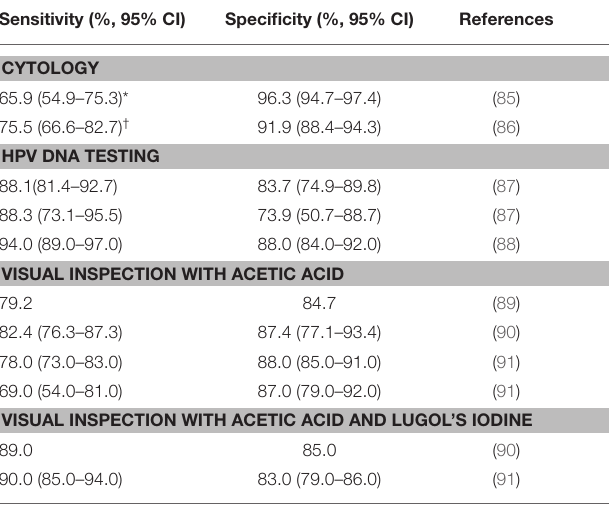
TABLE 4 | Summary of sensitivity and specificity of cervical cancer screening methods for detecting